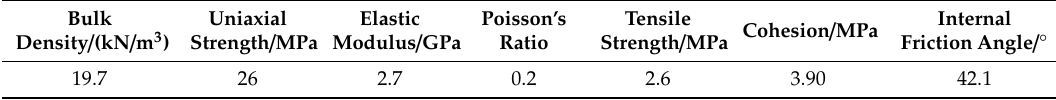
Table 1. Test results of the mechanical